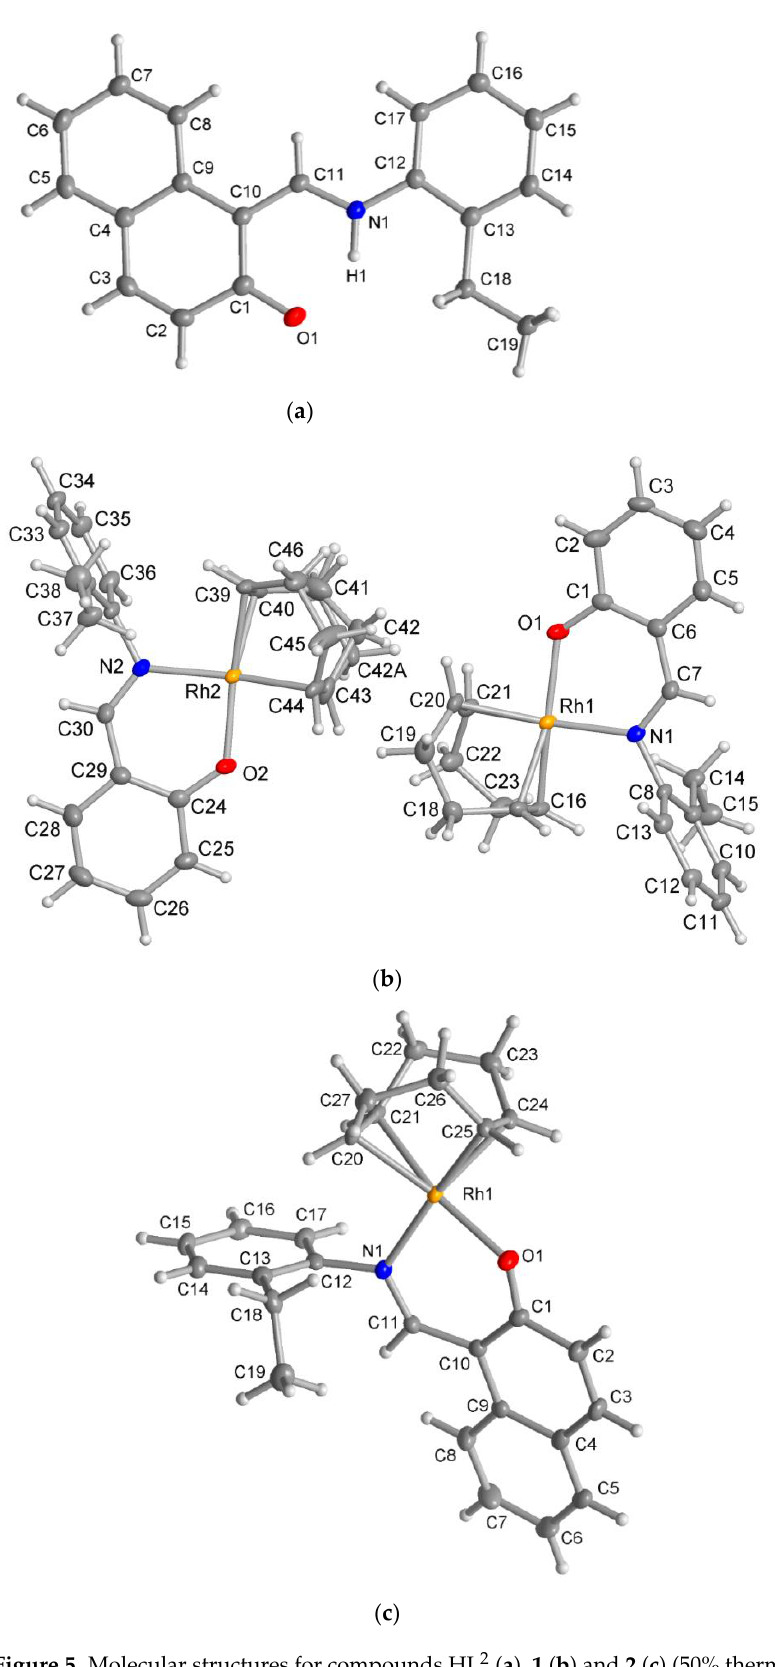
Figure 5. Molecular structures for compounds HL 2 ( a ), 1 ( b ) and 2 ( c ) (50% thermal ellipsoids). There is a disorder in the cod ring in the Rh2 molecule in 1 .